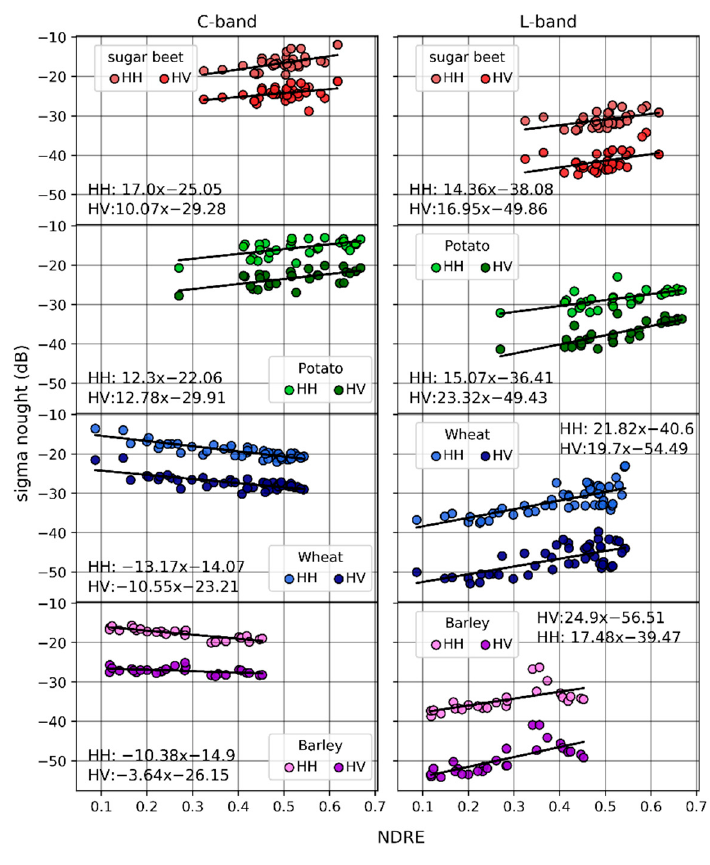
Figure 13. Scatter plots between Normalized Difference Red-Edge (NDRE) index and backscattering signal from co- and cross-polarized channels of C- and L-band airborne data. Table 7. R² and RMSD of the linear regression between backscattering signal and NDRE.